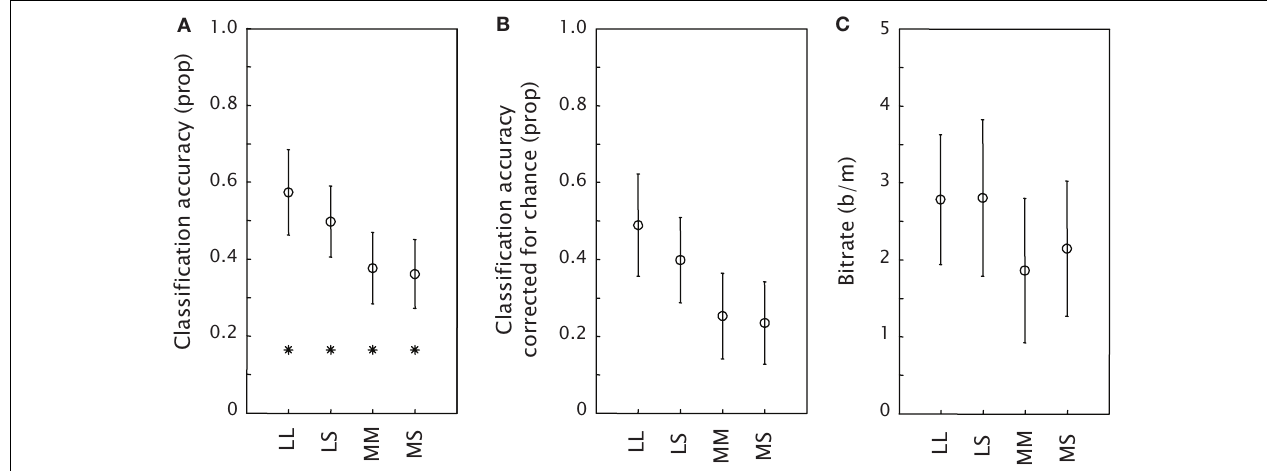
FIGURE 6 | Mean performance of the classifi cation model in the four conditions of Experiment 2b as expressed by classifi cation accuracy (A), classifi cation accuracy corrected for chance (B) and bitrate (C). The stars in (A) indicate chance performance. LL: Long On–Long Off, LS: Long On–Short Off, MM: Medium On–Medium Off, MS: Medium On–Short Off. Error bars represent standard errors of the